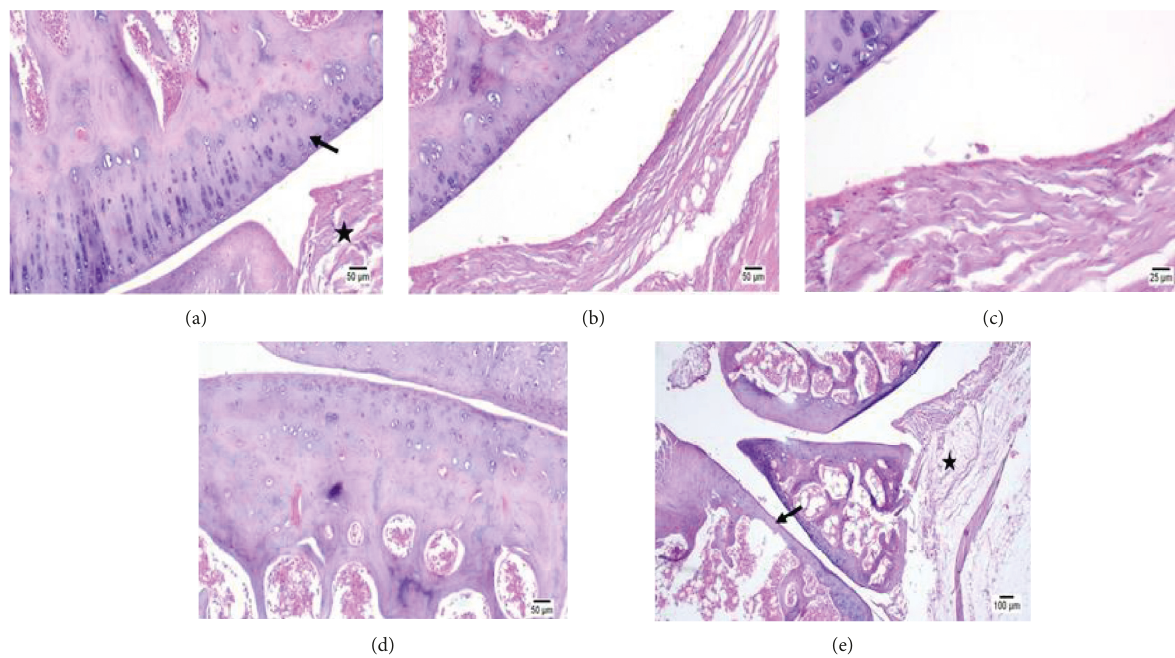
Figure 7: (a) Group (100ppm) showing normal articular cartilage, (b) normal articular cartilage (arrow) and synovium (star), (c) showing normal synovium and joint capsule, (d) higher magnification showing normal synovium and joint capsule, and (e) showing normal bone of the epiphysis.